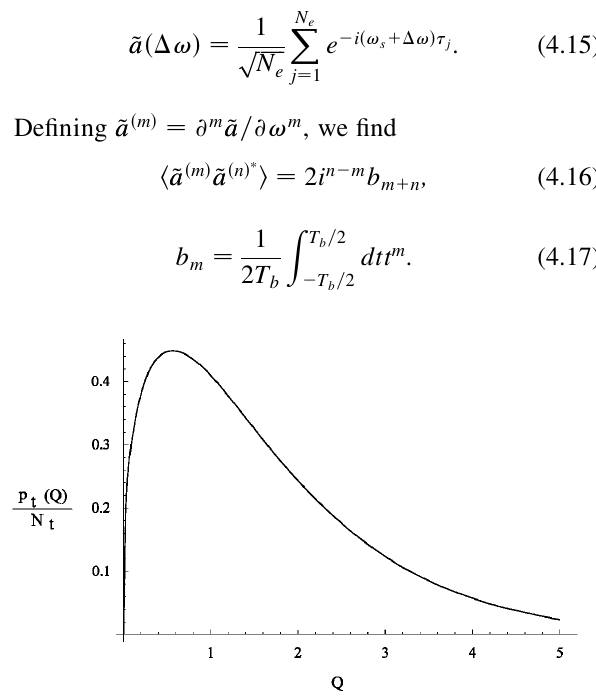
(cid:1) Q (cid:2) =N dQ is the probability of a peak in the time FIG. 3. p t t domain having normalized intensity between Q and Q (cid:12) dQ (dimensionless variables).